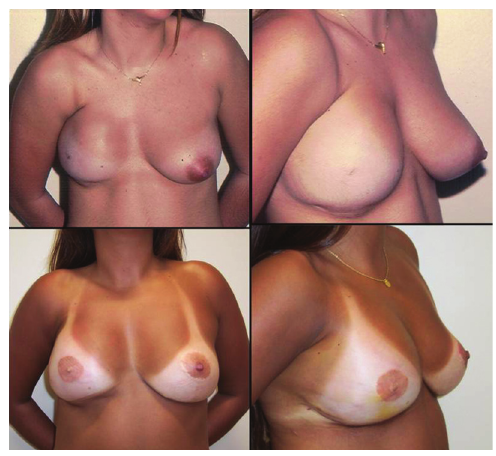
Figure 5 - Top: A Poland’s syndrome patient missing the right breast who was treated with a tissue expansor and prosthesis and has an unpleasant transverse sulcus in the axillary pillar, an infraclavicular depression and an anomalous breast contour. Bottom: The same patient after a laparoscopi- cally harvested omentum flap transposition to the right side that covers the prosthesis and conceals the infraclavicular depression and the anomalous breast contour. A mastopexy was performed on the opposite side in order to achieve a symmetric result.